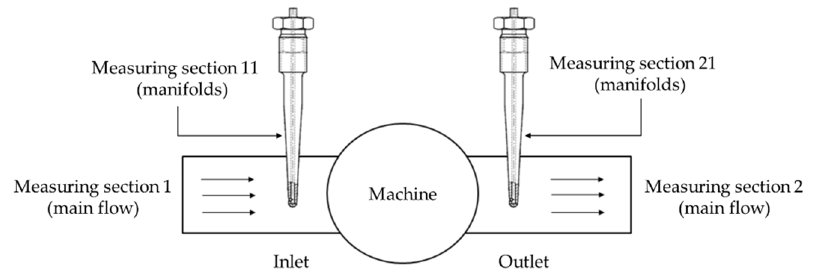
Figure 1. Conceptual diagram showing the location of manifolds to measure flow properties to compute power and efficiency according to IEC—60041.